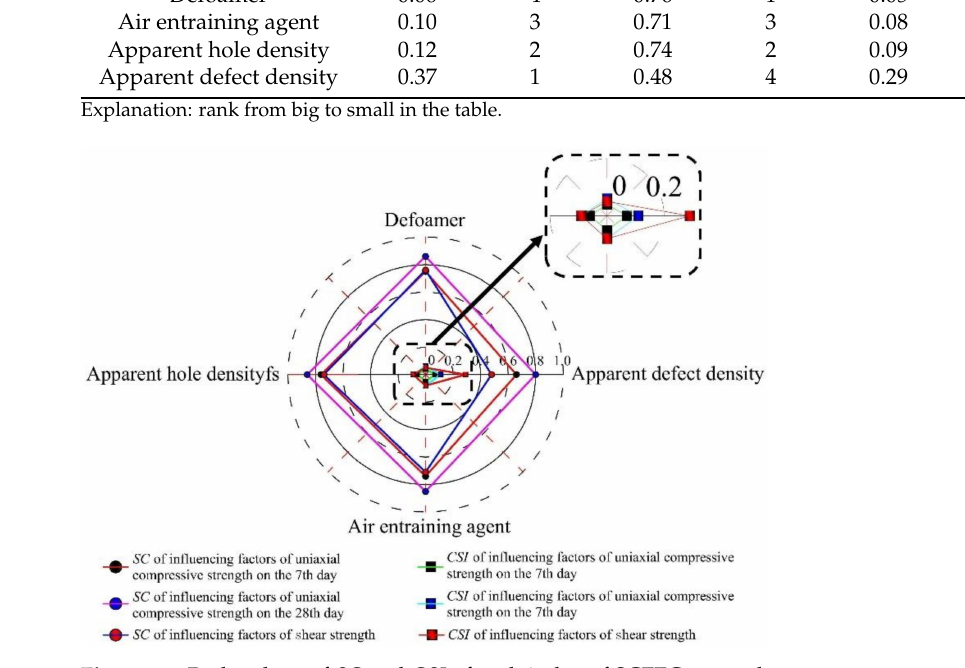
Figure 16. Radar chart of SC and CSI of each index of SCFFC